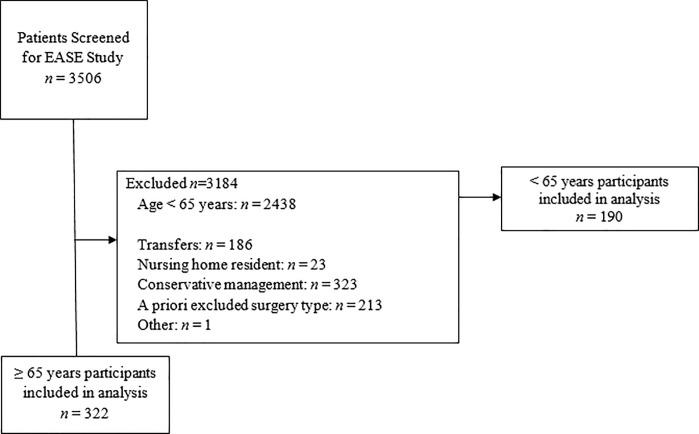
Selection of post-hoc analysis cohort.